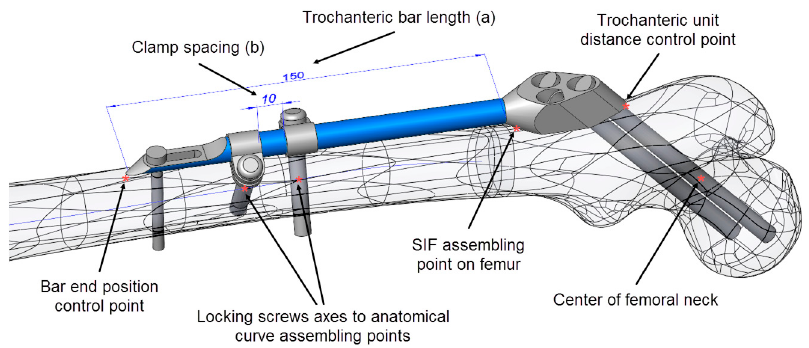
Figure 3. Driving design parameters (bar length ( a ) and clamp spacing ( b )) and specific points on the computer-aided design (CAD) model.